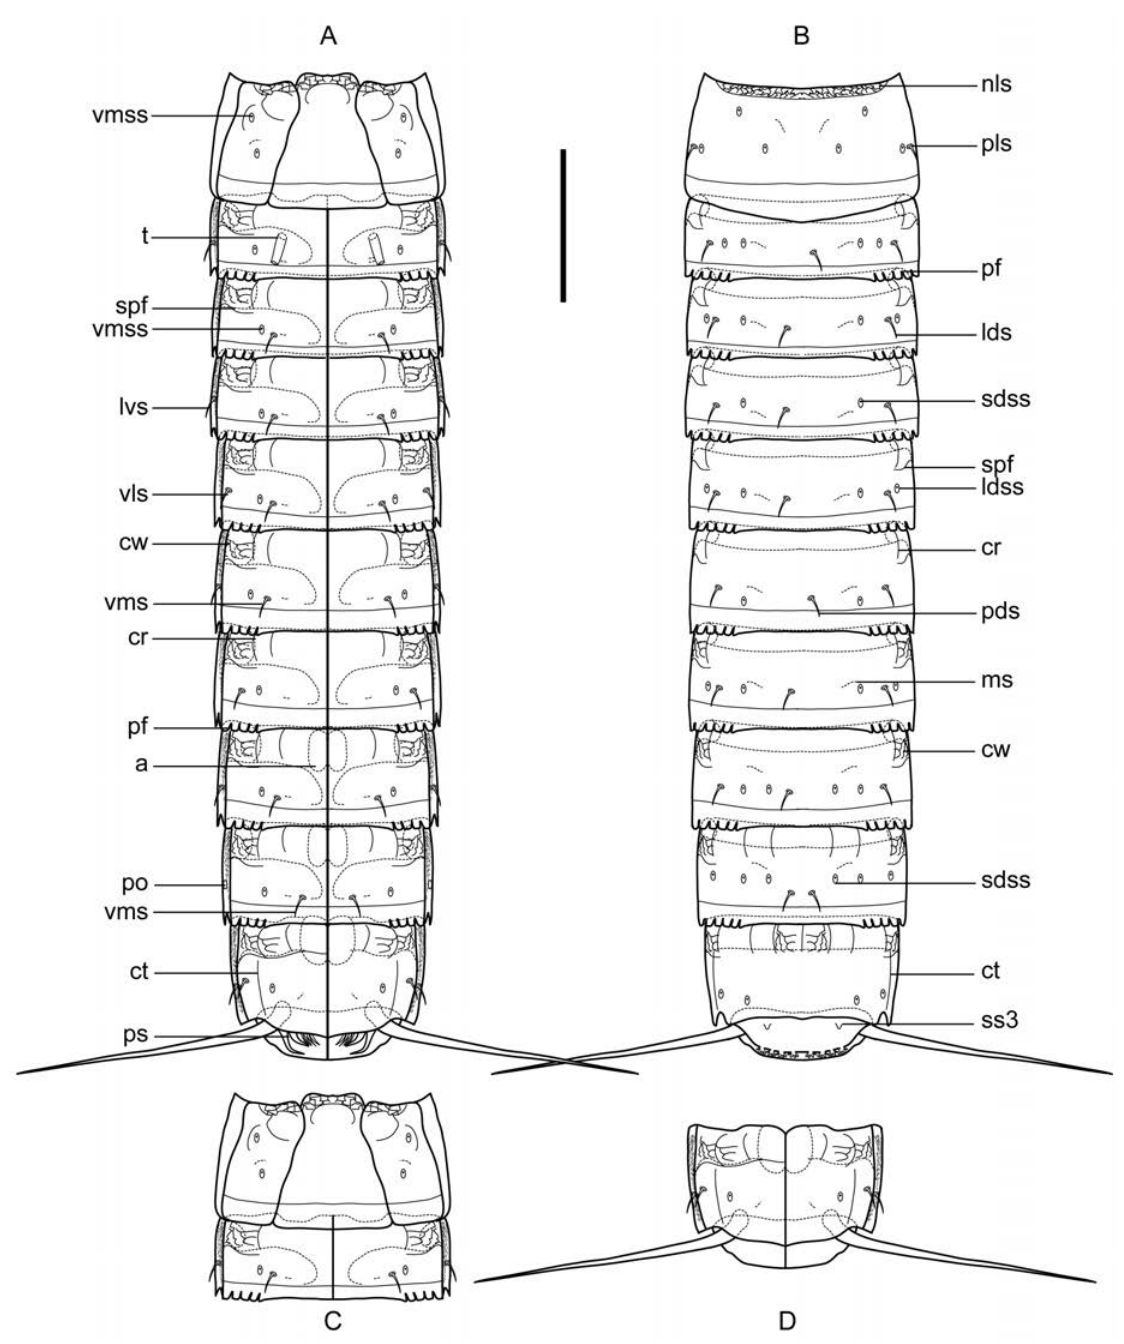
cuticular hairs (Fig. 3K). Segment 1: Anterolateral margins of tergal plate project into horn-like extensions. Tergal anterior mar- gin of the segment strongly denticulated, followed by